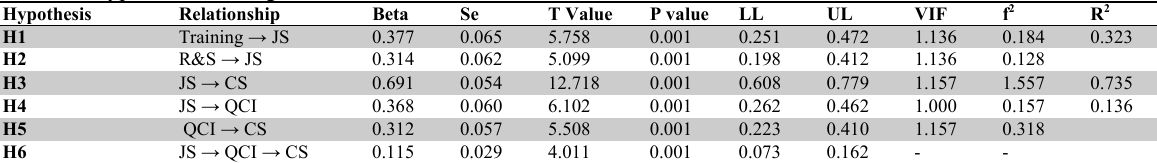
Results of Hypotheses